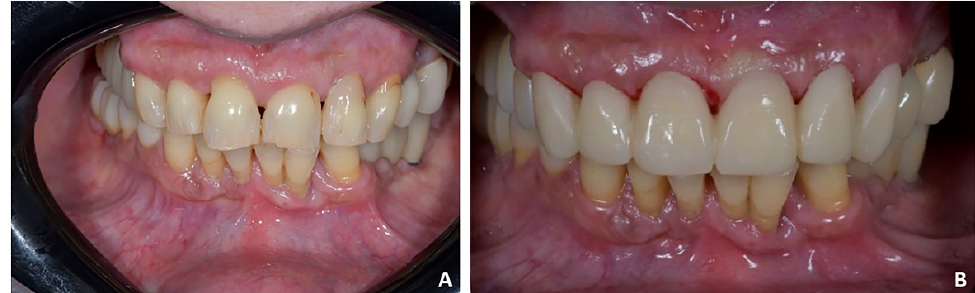
Figure 19. Case 3. ( A ) Posterior temporary crowns were replaced with monolithic zirconia crowns screwed on implants; ( B ) provisional crowns in the upper anterior segment from 1.3 to 23.